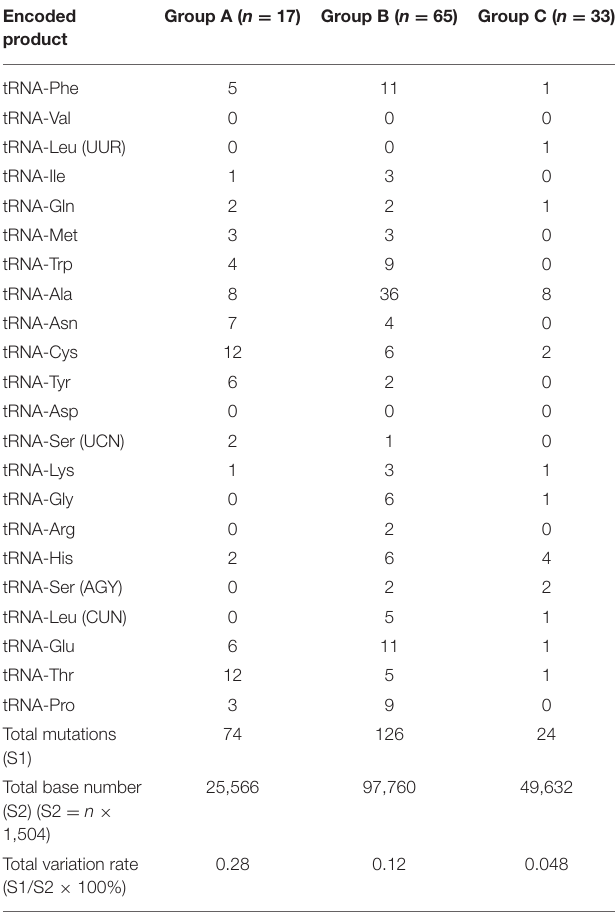
TABLE 1 | Mitochondrial tRNA mutations within each group. Encoded